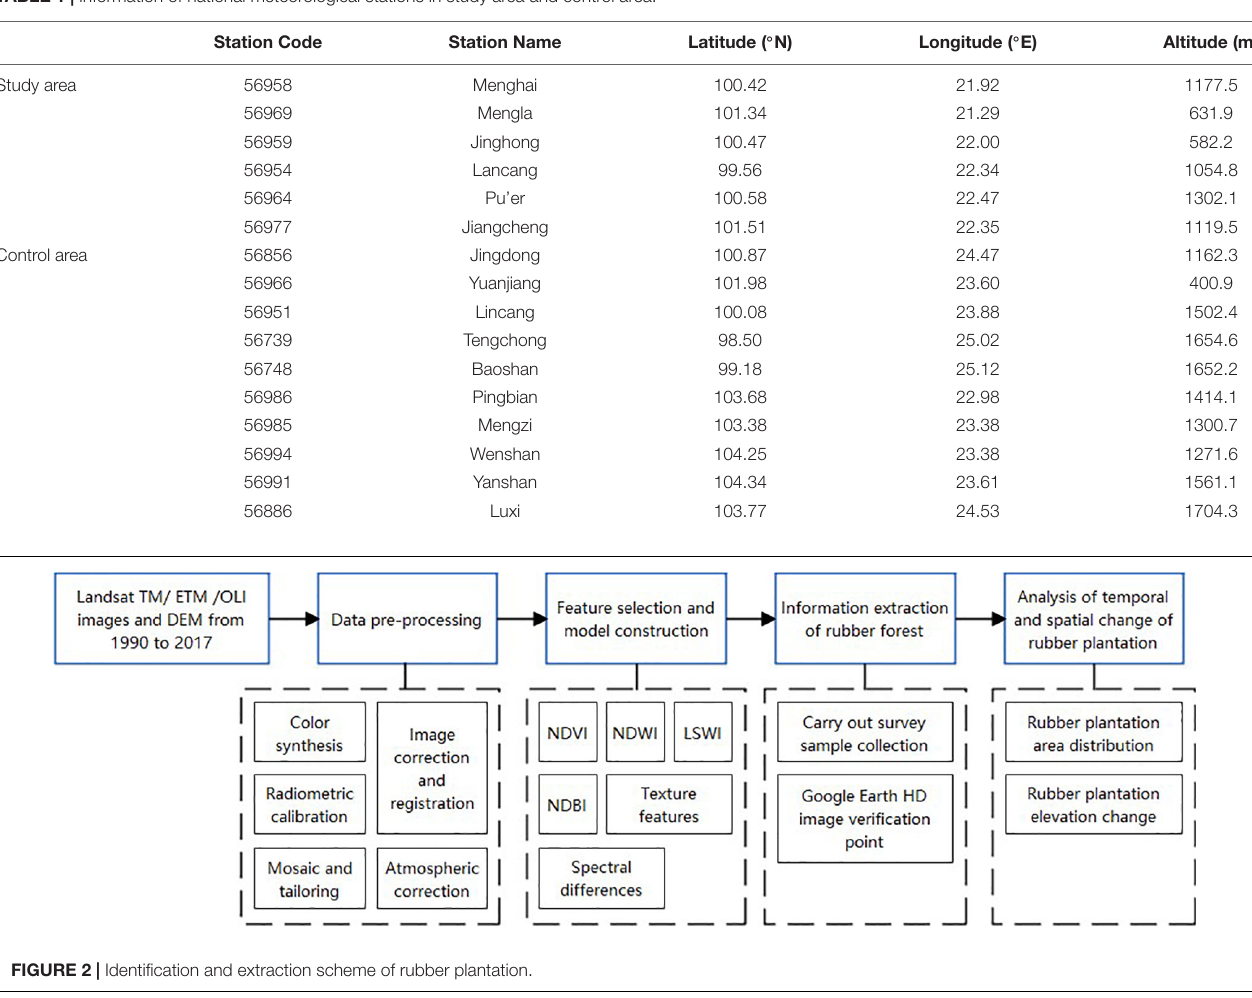
TABLE 1 | Information of national meteorological stations in study area and control area.